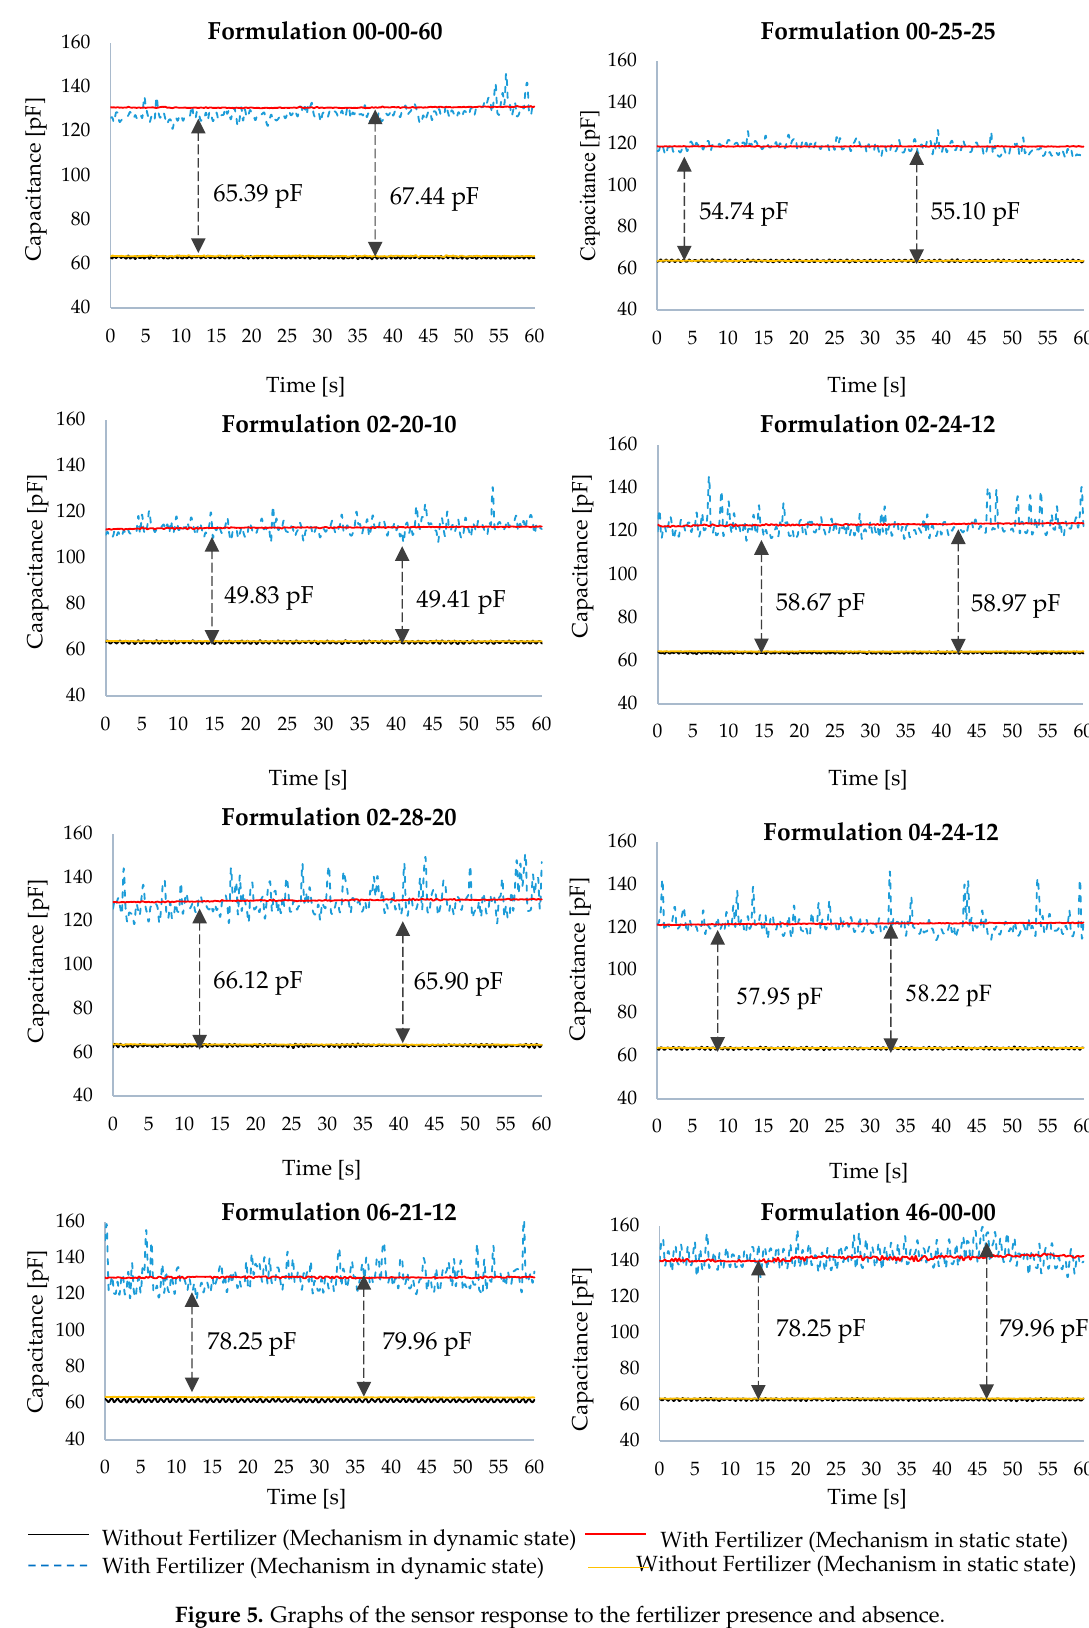
Figure 5. Graphs of the sensor response to the fertilizer presence and absence.